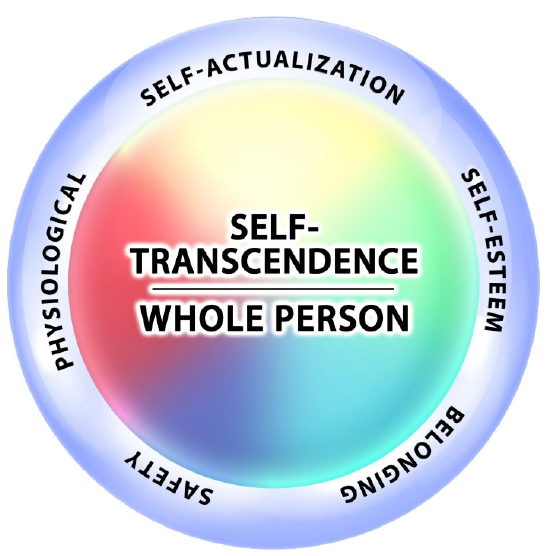
Figure 4. Maslow’s addition of self-transcendence, Maslow re-visited his work and added one more need, self ‐ transcendence—the peak experience of the whole person.